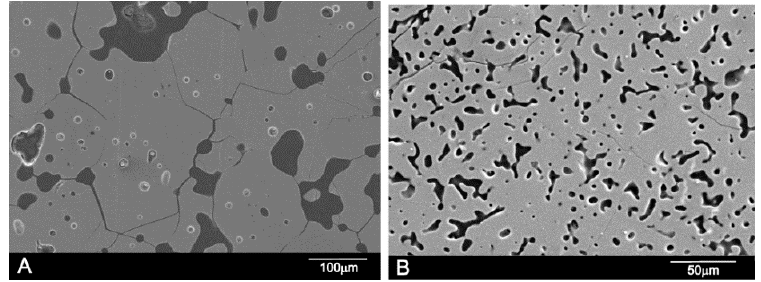
Figure 8. SEM images of sample ( A ) 7.69 wt % A/92.31 wt % S; and ( B ) 90.48 wt % A/9.52 wt % S.